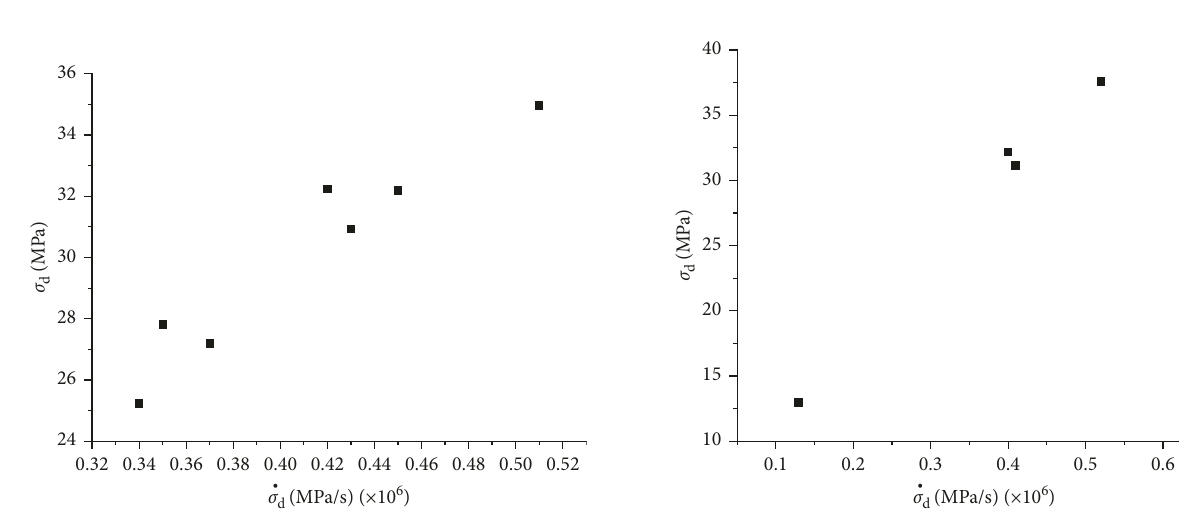
Figure 4: Relationship between dynamic tension strength and loading rate at depth 350m.